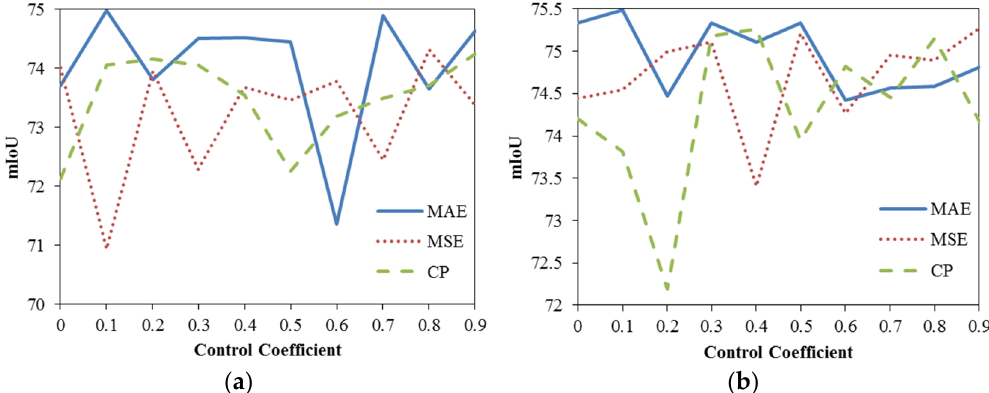
Figure 4. Comparison of segmentation results with different type of weighted loss function and different value of control coefficient. ( a ) The pixel-concentration distribution of forest fire smoke is R gc ; ( b ) The pixel-concentration distribution of forest fire smoke is λ .